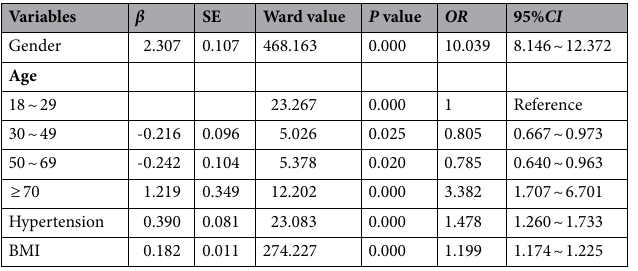
Table 2. The results of multivariate logistic regression analysis on the occurrence of hyperuricemia.